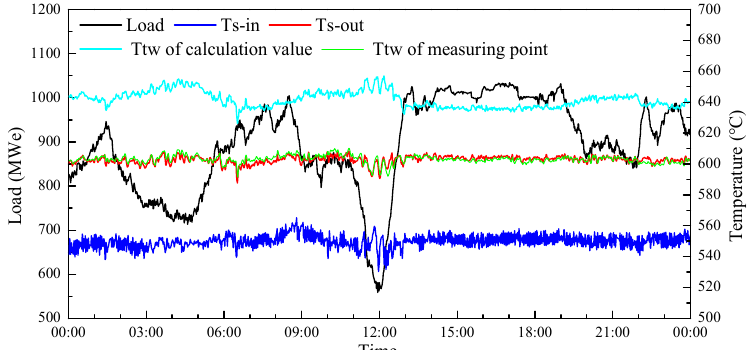
Figure 12. Tube wall temperature variation along the steam flow under two different load cases. The continuous 24-h on-line calculation results of the maximum tube wall tempera- ture (at the position of working fluid outlet) of the first serpentine on the 50th tube platen of the FSH are shown in Figure 13. As a peak regulation unit, the unit load changed within